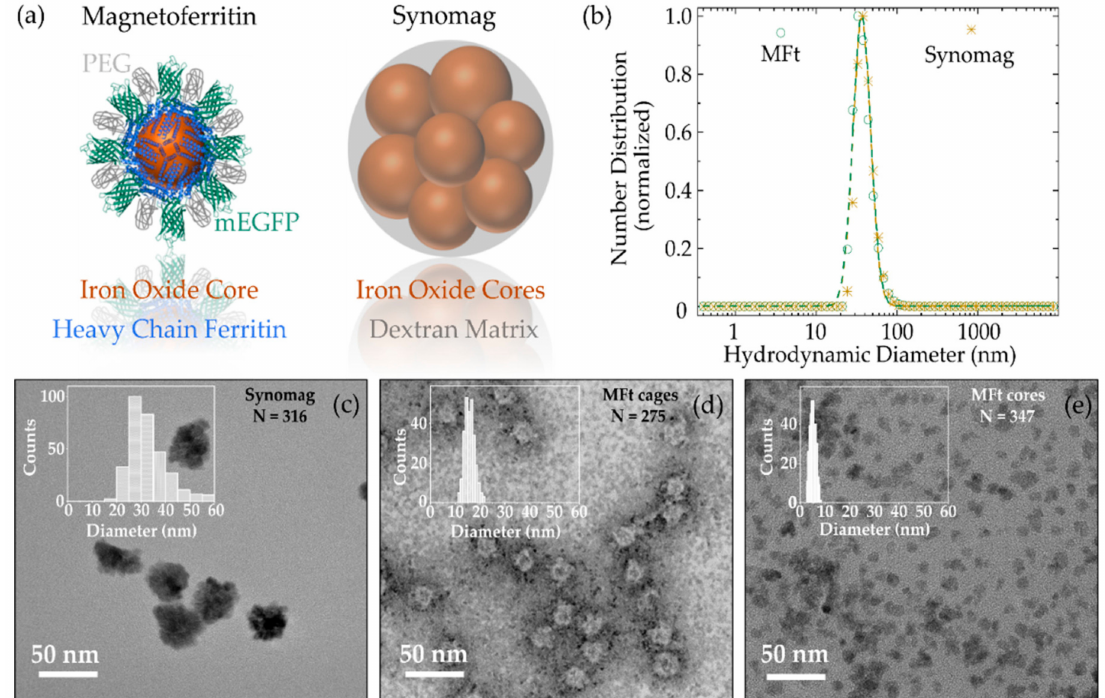
Figure 1. ( a ) Morphology sketches for magnetoferritin (MFt, parts created with permission of [30]) and synomag nanoparti- cles (NPs). ( b ) Number distribution for MFt (green) and PEGylated synomag (yellow) obtained by dynamic light scattering. Transmission electron microscopy images of ( c ) synomag, ( d ) MFt protein cages stained with uranyl acetate, and ( e ) MFt cores unstained. PEG = polyethylene glycol, mEGFP = monomeric enhanced green fluorescent protein, D H = hydrodynamic diameter, N = number of evaluated